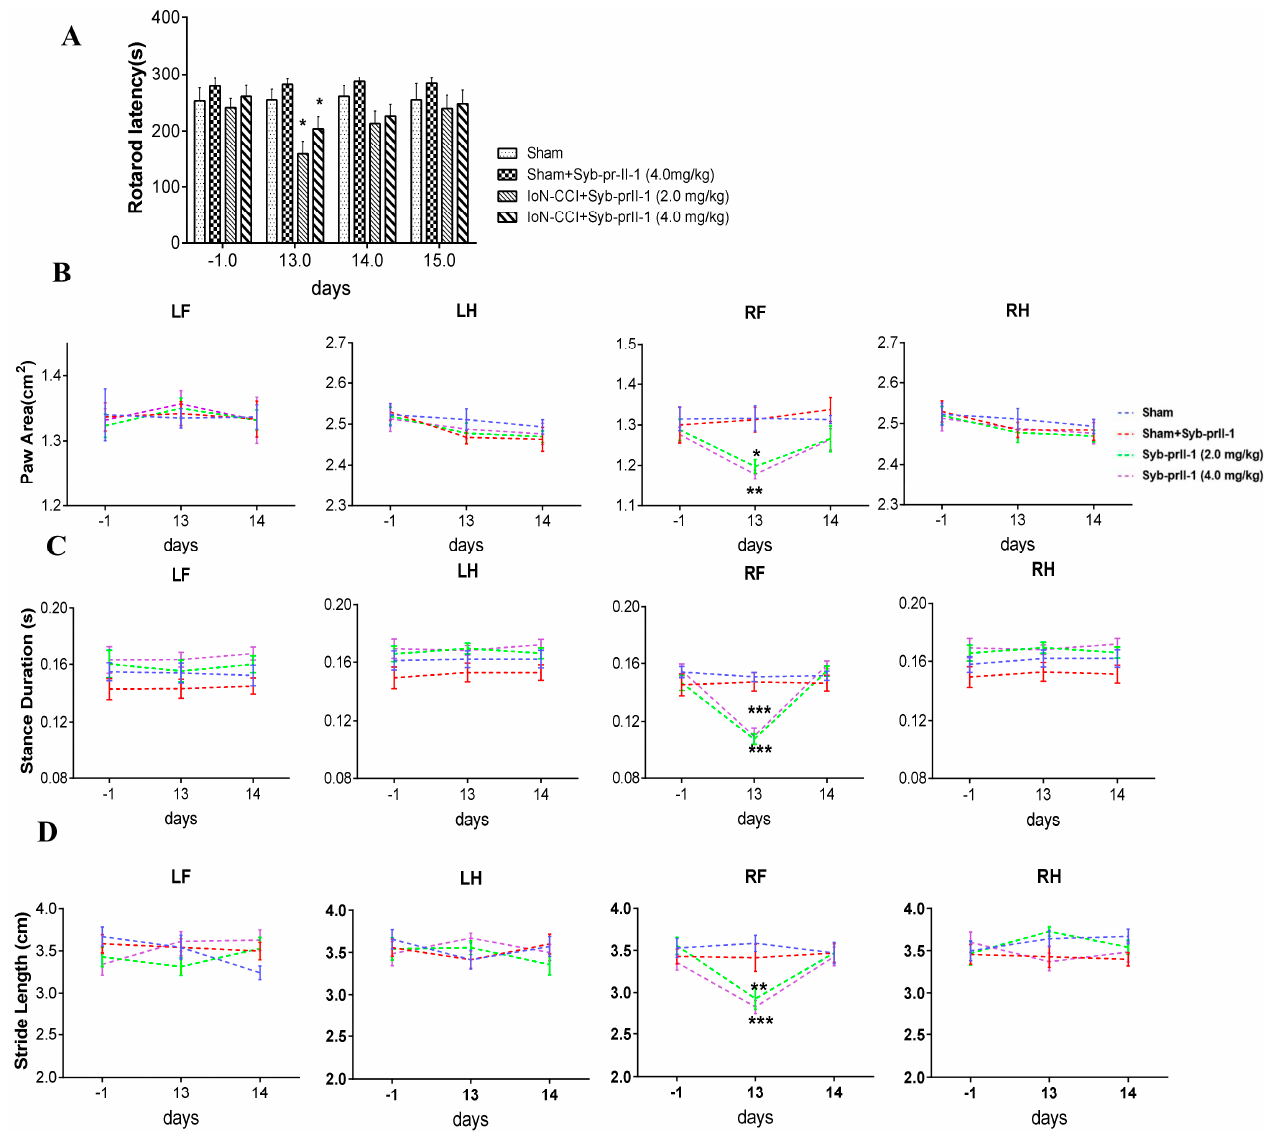
Figure 1. Changes in accelerated rotarod and gait analysis. ( A ) The effect of Syb-prII-1 on the accelerated rotarod experiment of IoN-CCI rats ( n = 12). ( B ) Effects of Syb-prII-1 on paw area following IoN-CCI operation in rats ( n = 8). ( C ) Effects of Syb-prII-1 on stance duration following IoN-CCI model established in rats ( n = 8). ( D ) Effects of Syb-prII-1 on stride length following IoN-CCI model established in rats ( n = 8). All data were presented as mean ± SEM. * p < 0.05, ** p < 0.01, *** p < 0.001 compared with sham group.